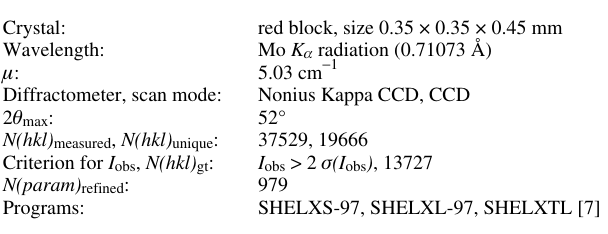
Table 1. Data collection and